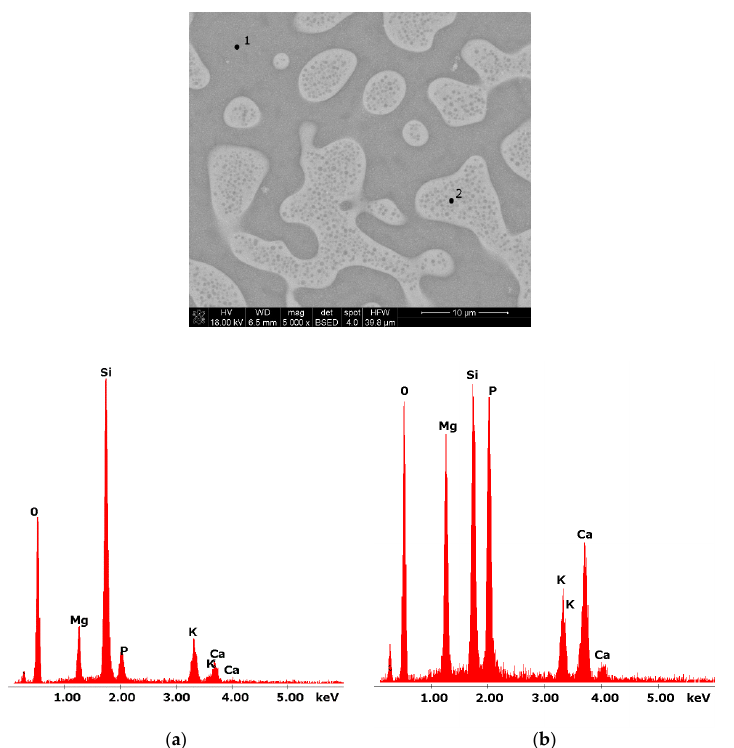
Figure 2. SEM microphotograph of 8B glass. (5000×) ( a ) EDS analysis of 8B glass (p.1); ( b ) EDS analysis of 8B glass (p.2).